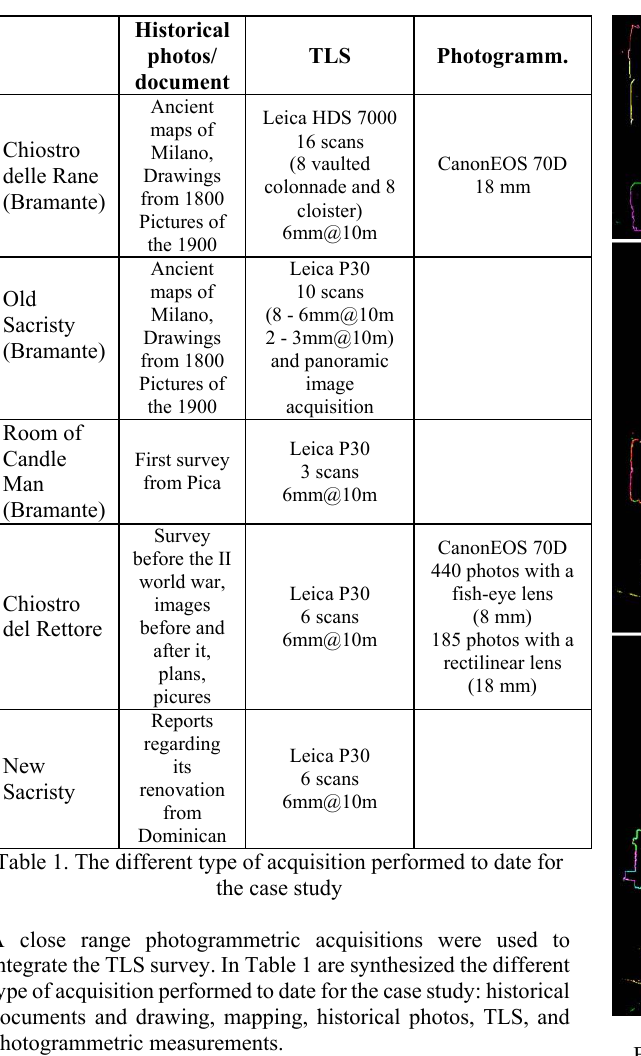
Figure 6. Horizontal and vertical slices of the aligned scans, represented with different colors: no misalignments are seen and in the zoom detailed the circular shape of the column is correctly